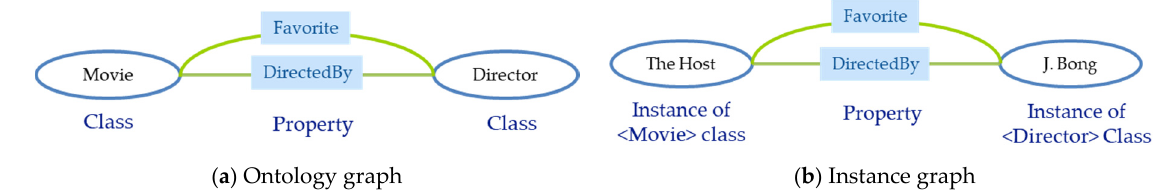
Figure 2. Example of ontology graph and instance graph.